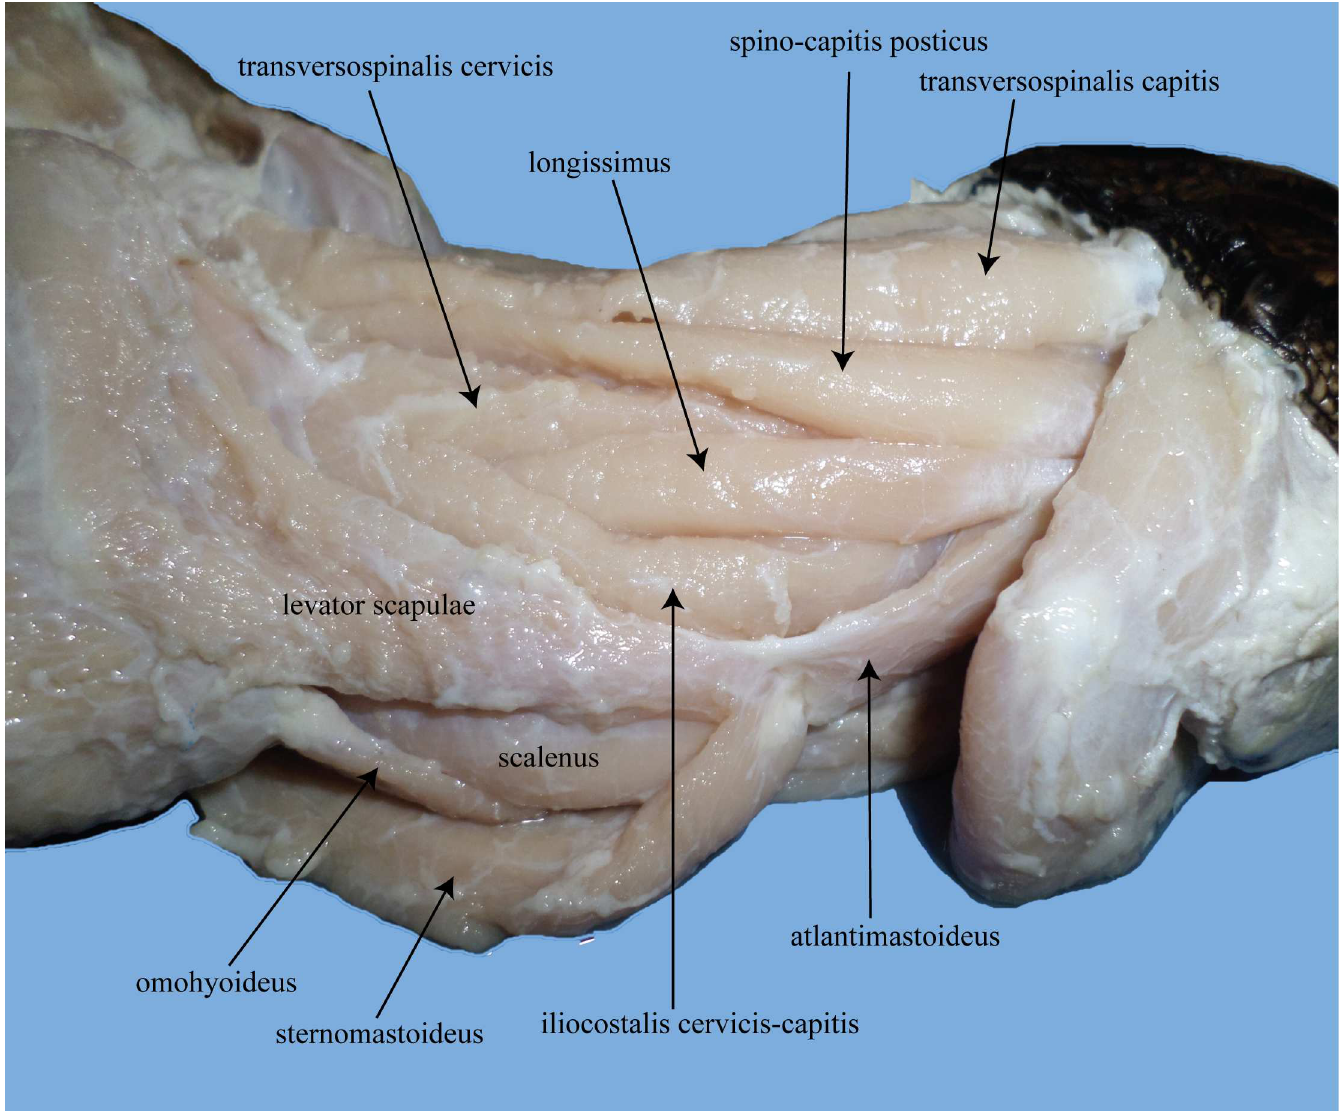
Fig 12. Lateralview of the cervicalmusculatureof Alligatormississippiensis . M . sternomastoideus is reflectedaway ventrally to expose the m . omohyoideus and m . scalenus